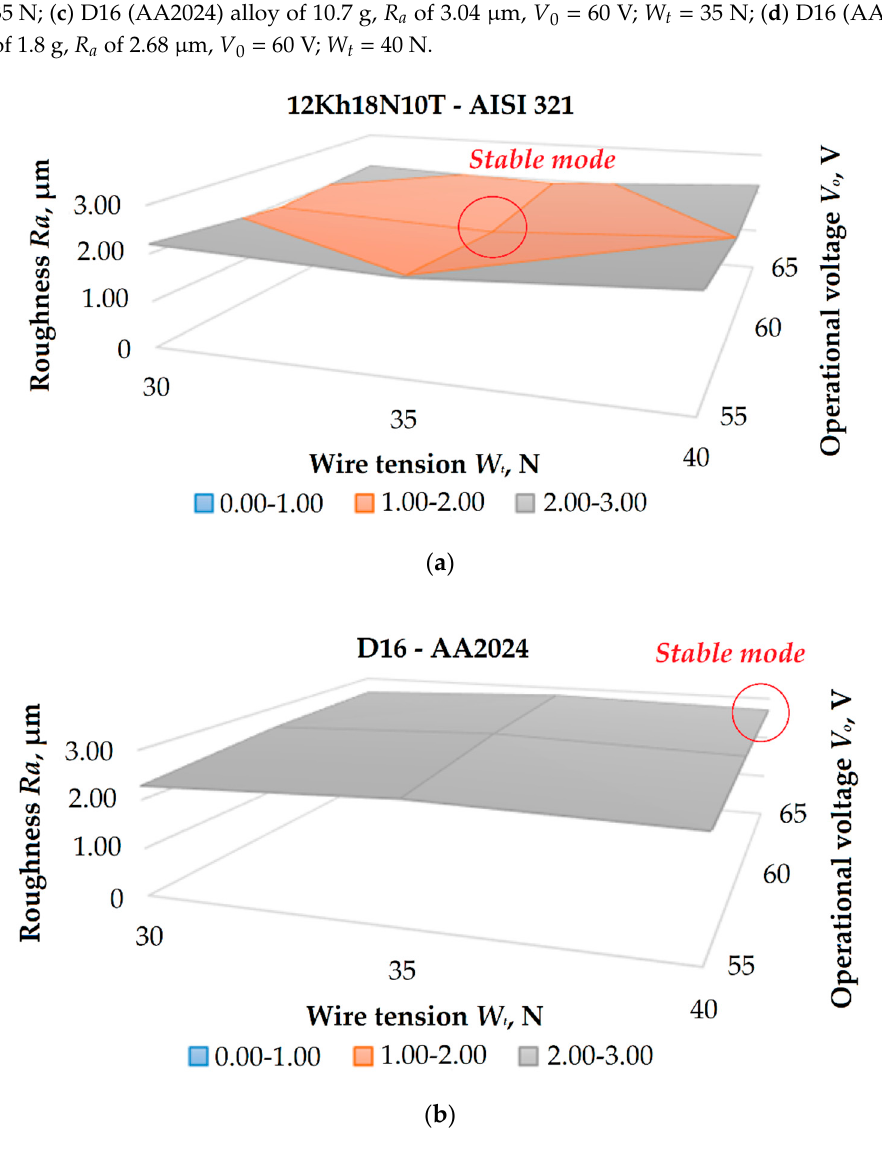
Figure 8. Three-dimensional (3D) graphs of the surface roughness R a dependences on operational voltage V 0 and wire tension W t : ( a ) 12Kh18N10T (AISI 321) steel; ( b ) D16 (AA2024) alloy.